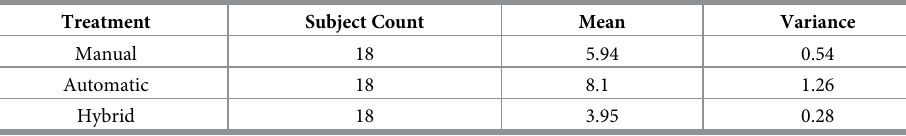
Table 21. Data summary—Viewpoint #7.